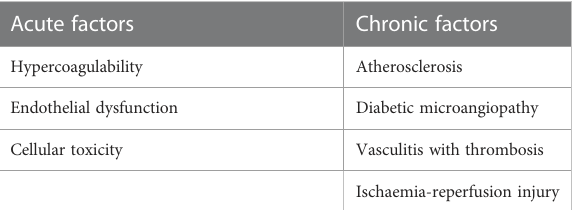
TABLE 2 Summary of possible pathogenesis of